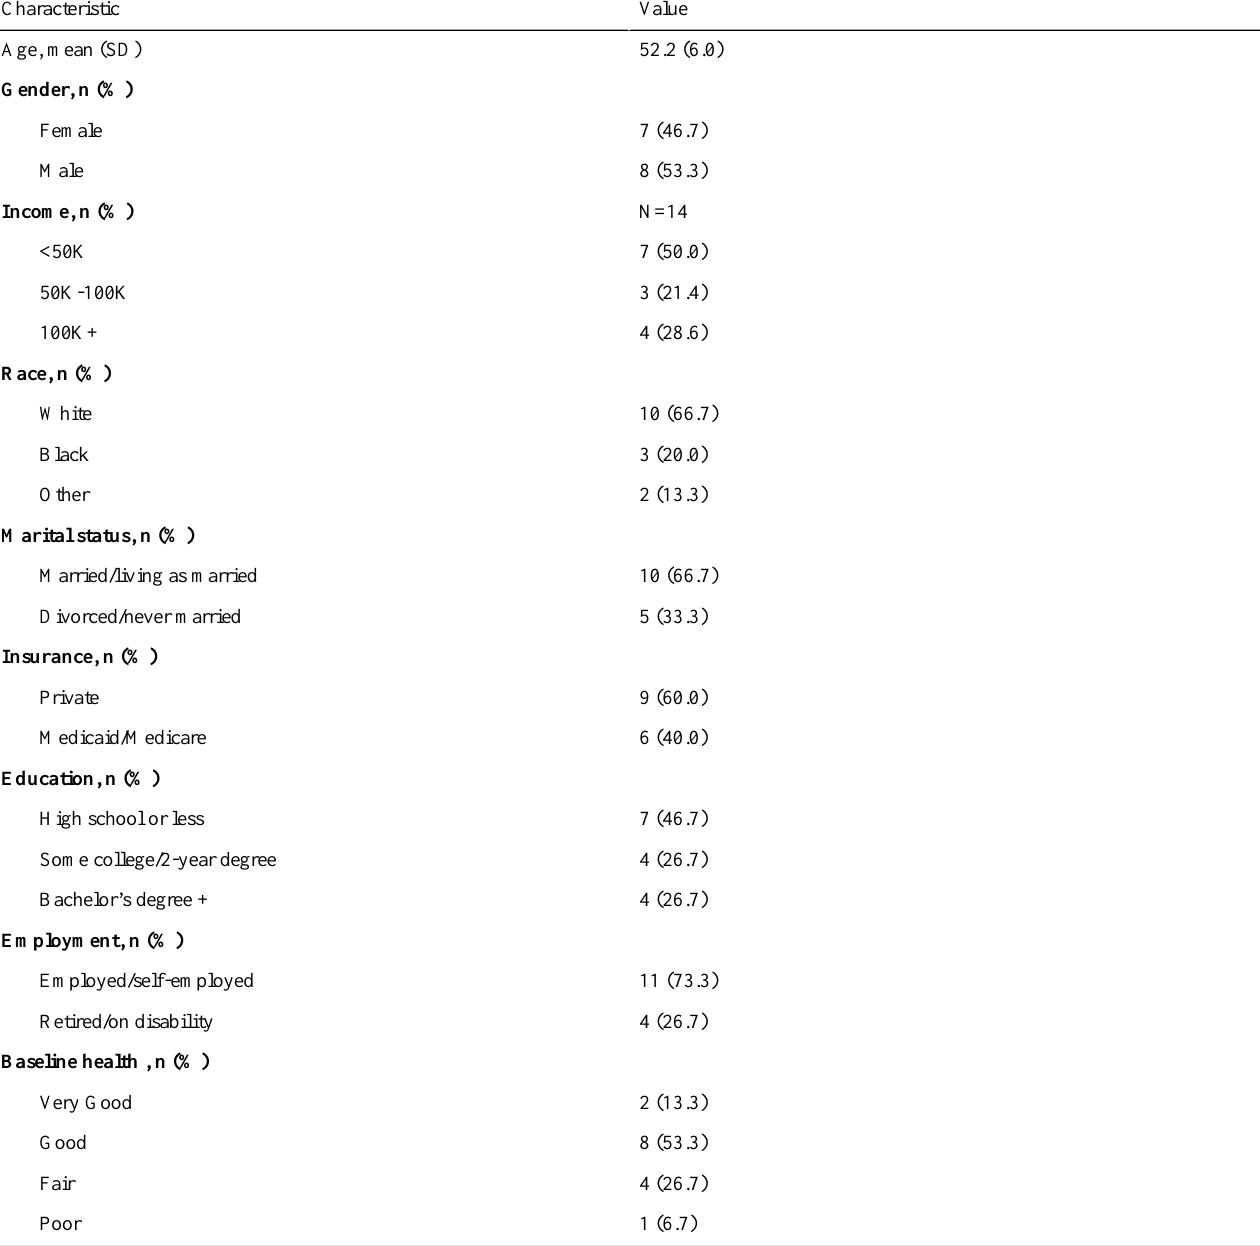
Table 1. Participant demographics (N=15).